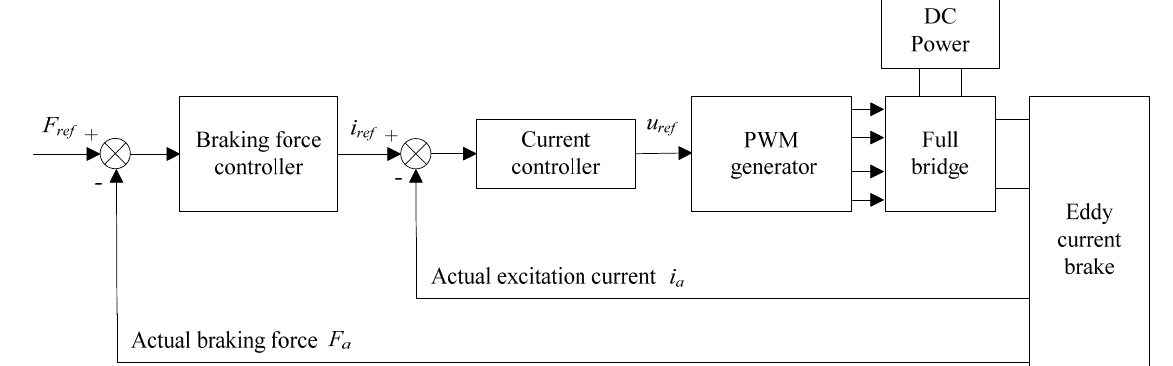
Figure 13. Control scheme of the eddy current